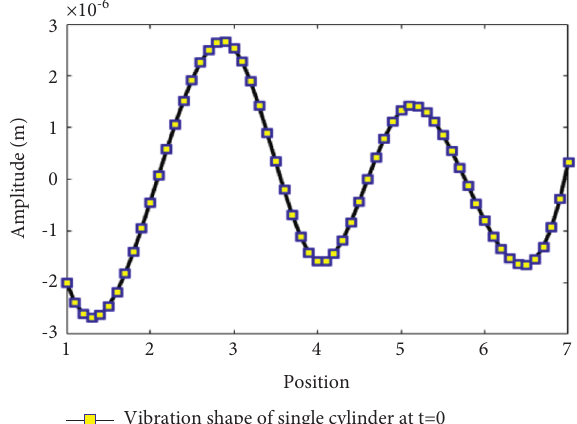
Figure 10: Vibration shape of a single cylinder at t � 0.